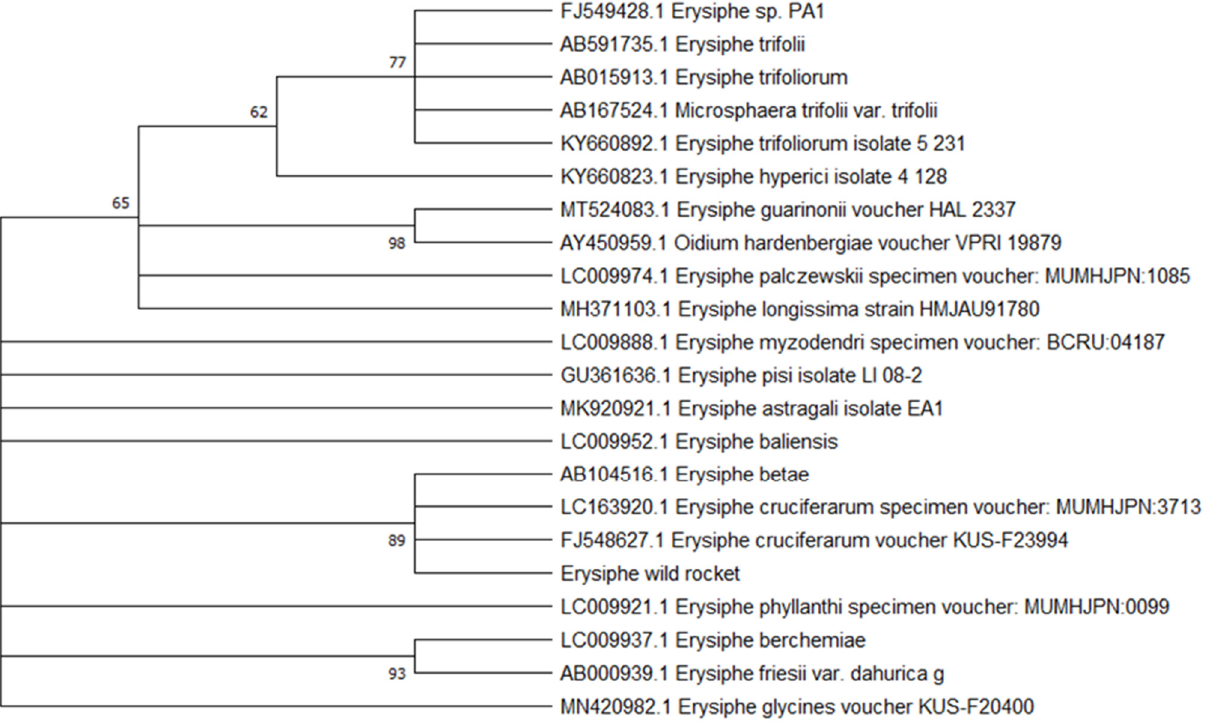
Figure 5. Phylogenetic tree inferred from partial ITS gene sequences of 22 powdery mildew sequences. The Erysiphe glycines sequence (MN420982.1) was used as the outgroup. The numbers above the branches denote the bootstrap values from 1000 replications. Bootstrap values ≥ 60% (maximum parsimony and maximum likelihood) and posterior probability ≥ 95% (Bayesian inference) are shown.